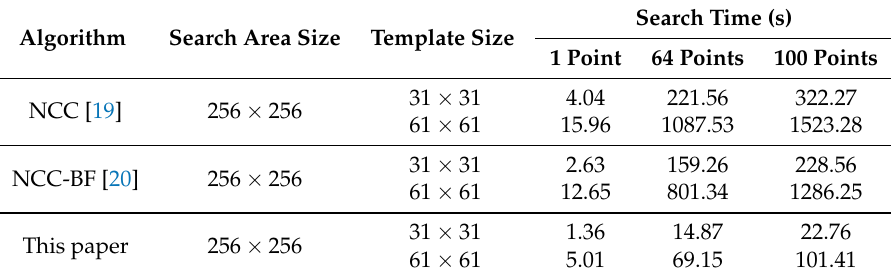
Table 2. Comparison of time consumption for three matching algorithms.